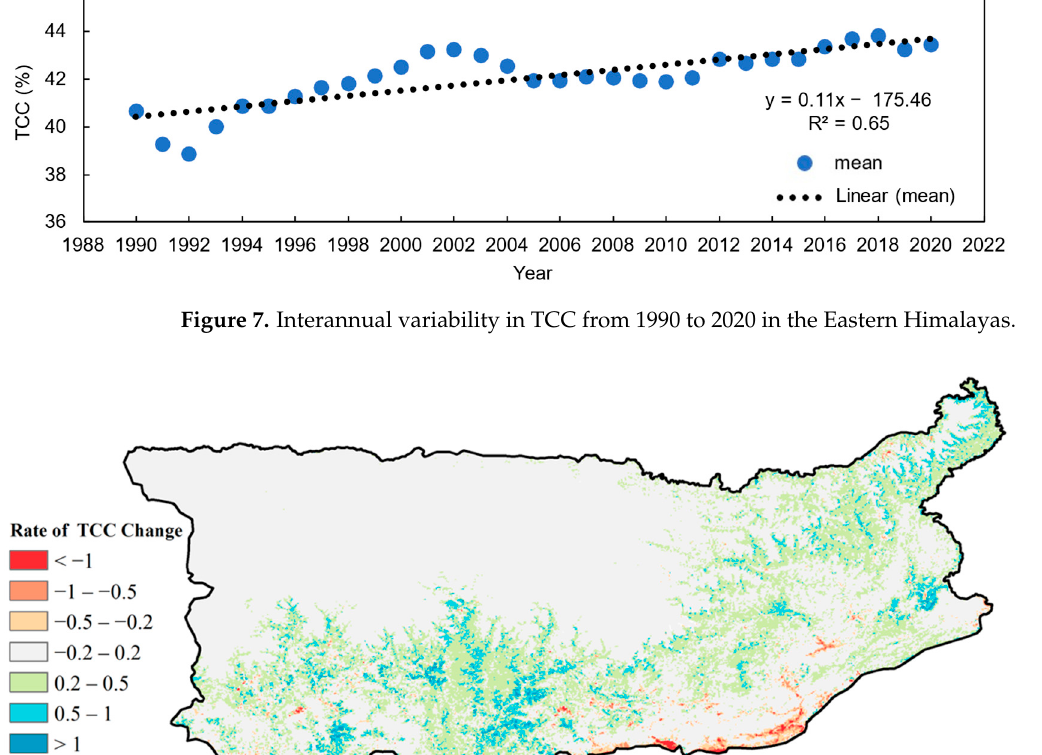
Figure 7. Interannual variability in TCC from 1990 to 2020 in the Eastern Himalayas.